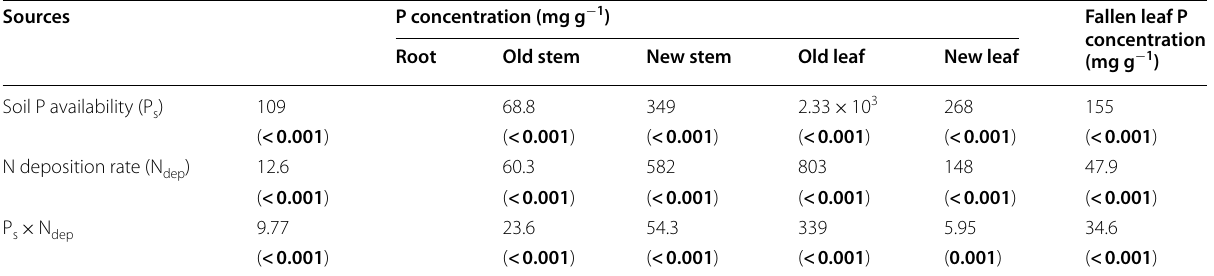
Table 2 Effects of soil P availability (P of P. edulis seedlings and fallen leaves ( n ( P < 0.05) are highlighted in bold